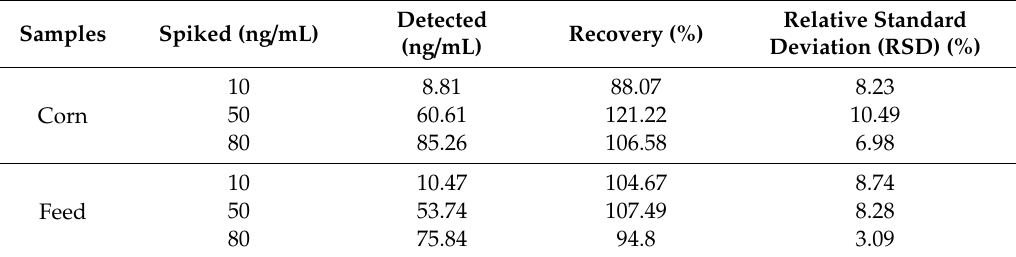
Table 2. Spike recovery experiment of corn and feed samples.